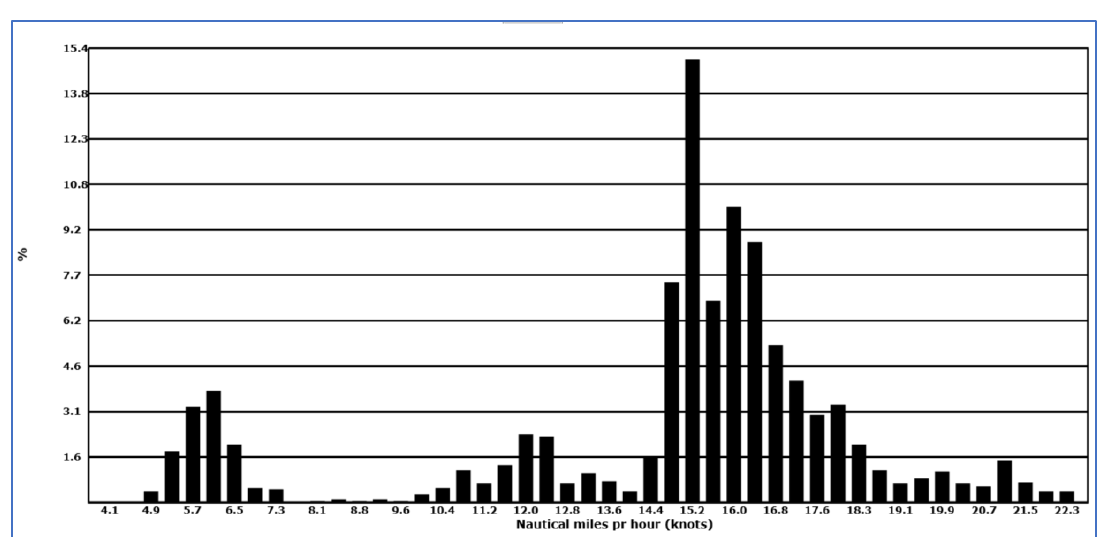
Figure 5. Speed profile for Artania (June 2017).